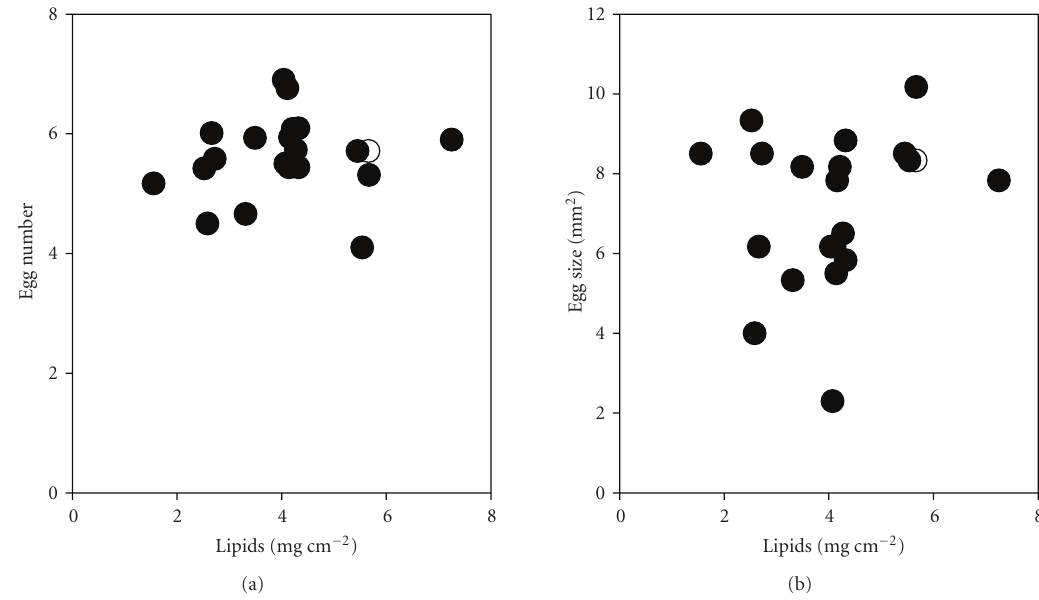
Figure 4: Scatterplots showing the significant correlations between prespawning lipids and (a) egg numbers ( r 2 = 0 . 01, P < . 001) and (b) egg sizes ( r 2 = 0 . 05, P = . 017) in Acropora millepora colonies in the year before a bleaching event.